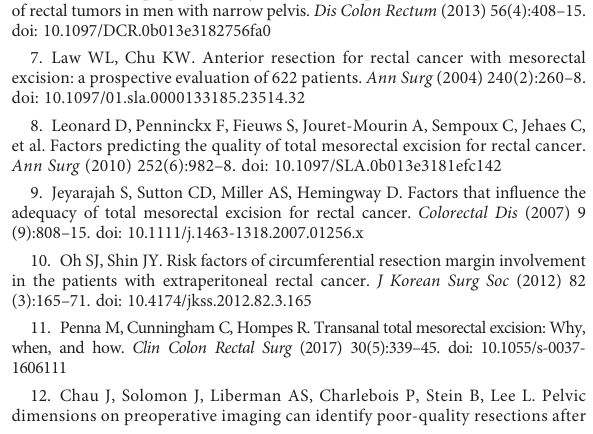
SUPPLEMENTARY FIGURE 1 Bland-Altman graphs. The solid blue line indicates the mean difference in readsbetweenthetworadiologists. Thedashedredlinesindicatethelimitsof agreement (LoA). (A) . Pelvic inlet. (B) . Pelvic depth. (C) . Pelvic outlet. (D) . Transverse diameter. (E) . Interspinous distance. F. Intertuberous distance. SUPPLEMENTARY FIGURE 2 Boxplots of pelvimetry based on surgical dif fi culty criteria. (A) . Operative time. (B) . Intraoperative blood loss. (C) . Postoperative hospital stay. (D) . Postoperative complication. Line 1. Pelvic inlet. Line 2. Pelvic depth. Line 3. Pelvicoutlet.Line4.Transversediameter.Line5.Interspinousdistance.Line6. Intertuberous distance. * p < 0.05, Comparison between two